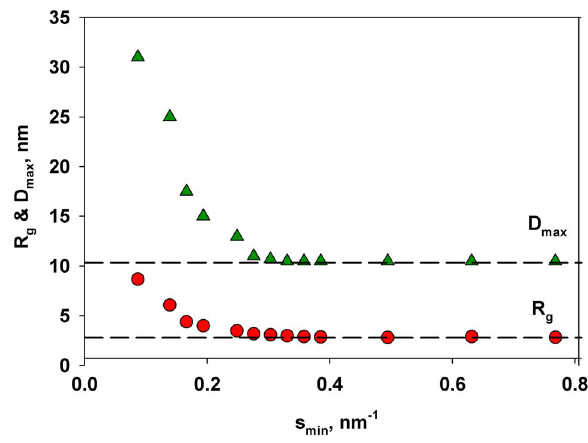
Figure 3. The R g and D max computed from the solution of the full length M1 protein as a function of the cut-off value at small